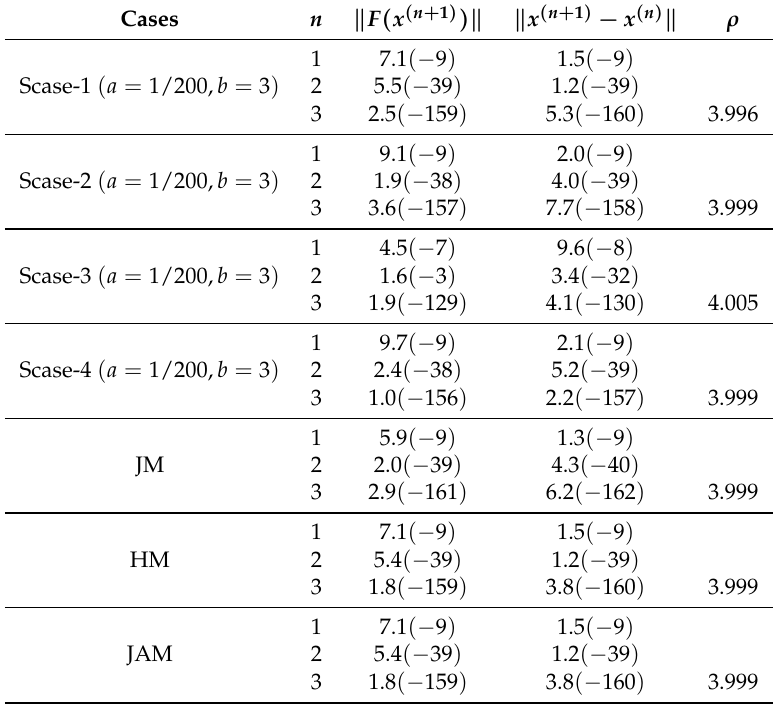
Table 7. Convergence behavior of different fourth-order methods for Example